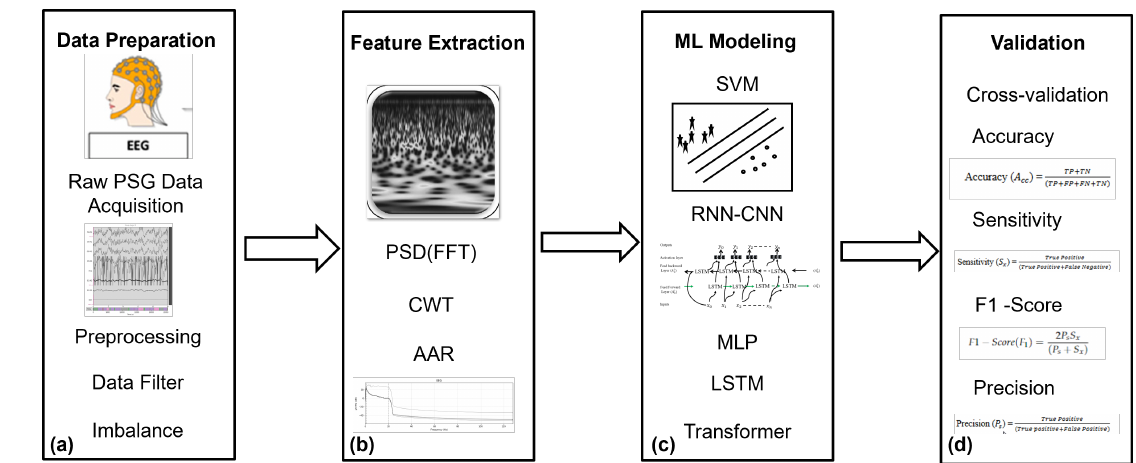
Figure 6. Overview of the process flow or steps of data preparation, feature extraction, ML model- ing, and classification. Note the nomenclature section for abbreviations in the above process flow image. ( a ) Data Preparation [64]. ( b ) Feature Extraction [65]. ( c ) Machine-Learning Modeling [66]. ( d )